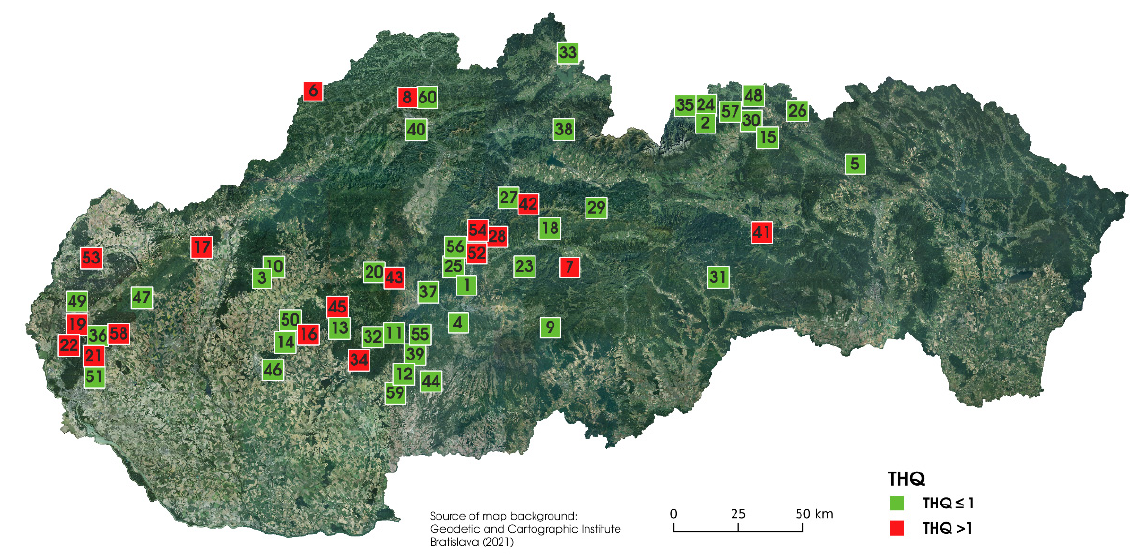
Figure 5. The values of THQ at the sampling sites, regardless of the mushroom species.